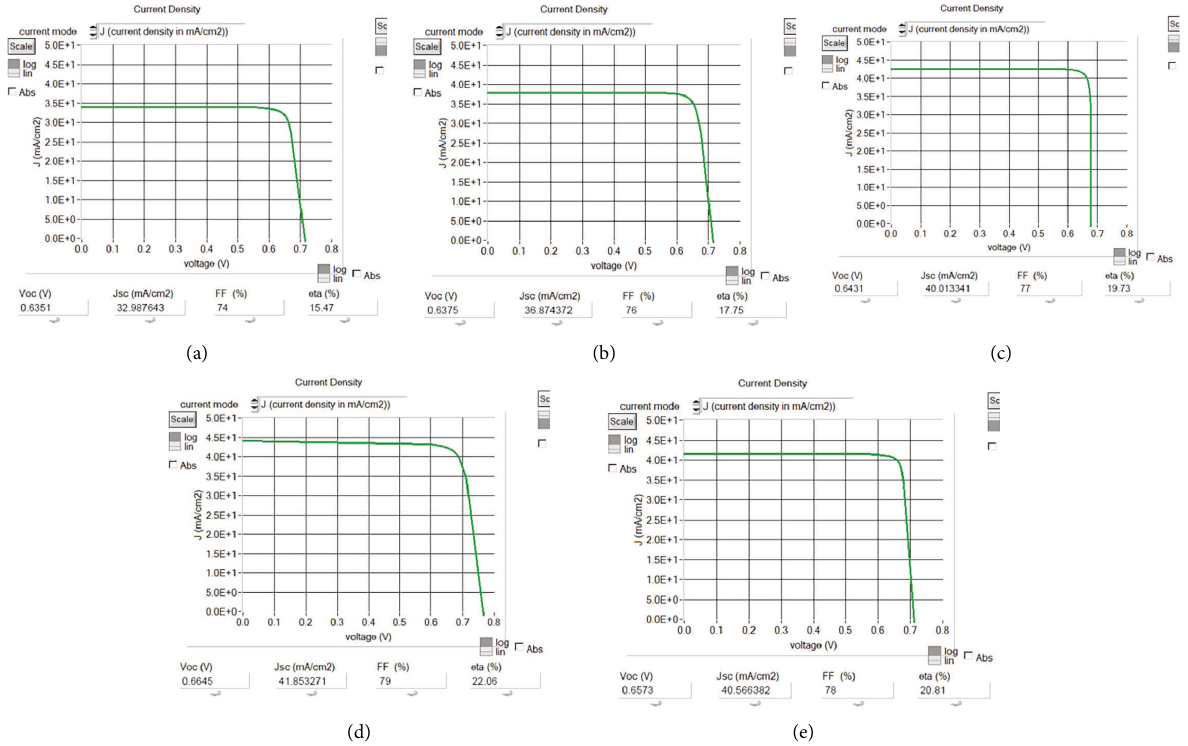
Figure 9: Simulation results of various coated and uncoated solar cells: (a) B-I; (b) B-II; (c) B-III; (d) B-IV; (e) B-V.